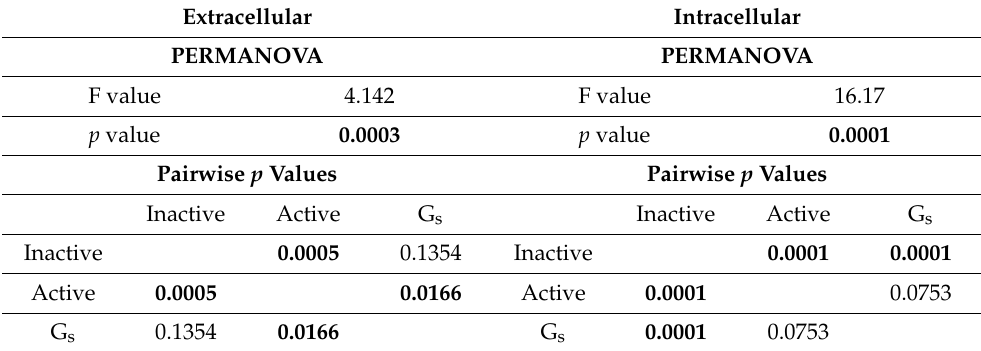
Table 3. A summary of PERMANOVA (distance) test data for the extra- and intracellular faces of the β 2AR receptors, to support Figure 3; 9999 permutations performed on PC1-5, significant p values (<0.05) are shown in